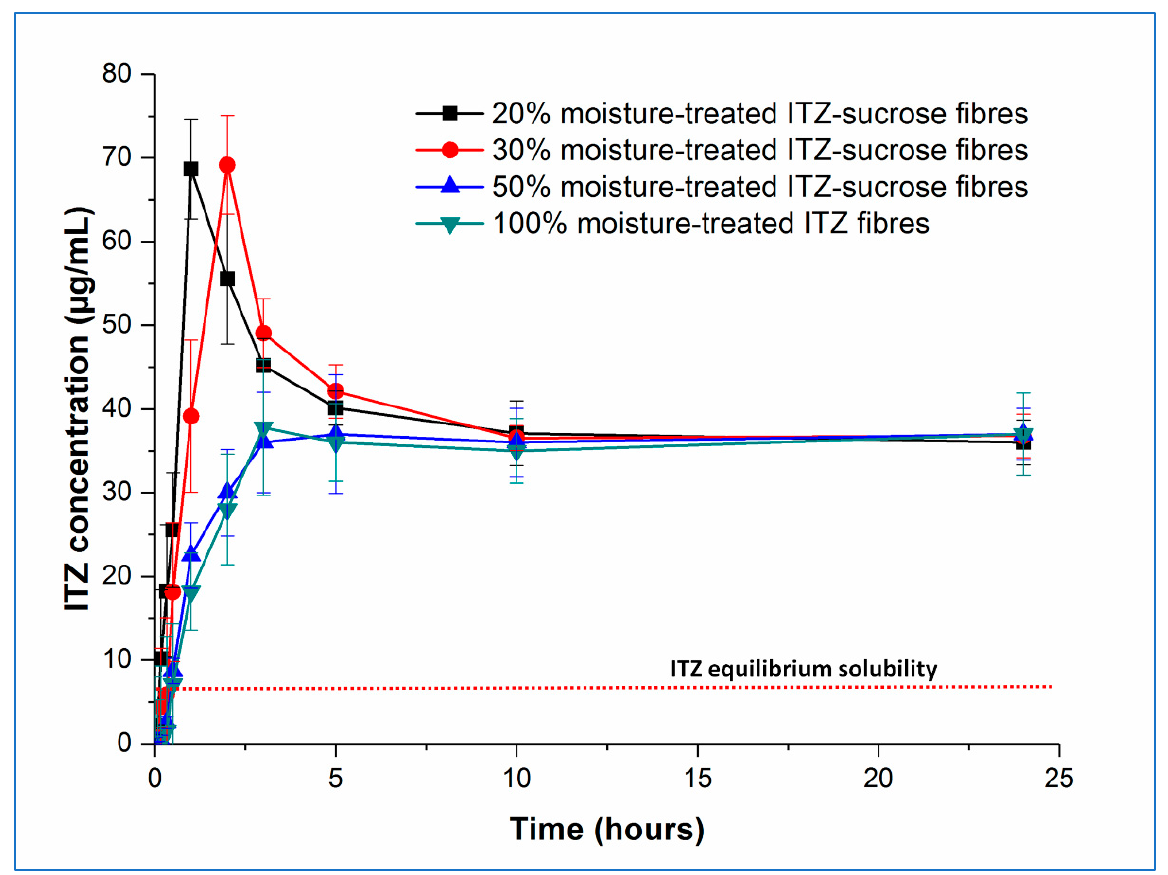
Figure 7. Dissolution–supersaturation profiles obtained under non-sink conditions for itraconazole- loaded sucrose microfibres (containing 20, 30, and 50% w / w itraconazole) and pure itraconazole microfibres after 30 days exposure to 25 °C/75% RH. The red dotted line indicates the equilibrium solubility of crystalline itraconazole. (ITZ = itraconazole).